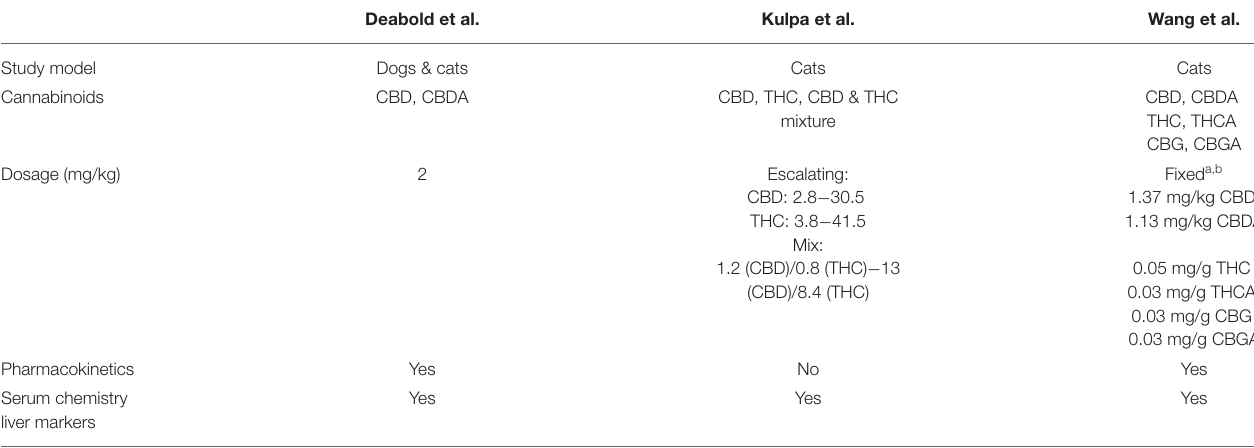
TABLE 3 | Current studies of cannabinoids in cats. Deabold et al. Kulpa et al. Wang et